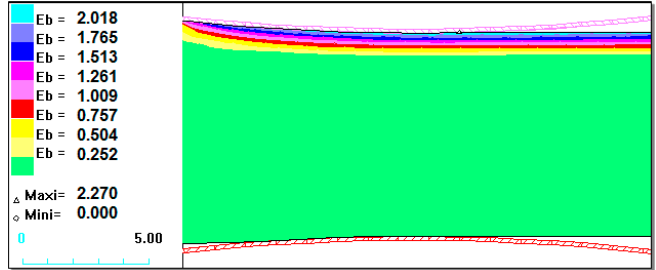
Figure 3. State of strain intensity for the Ni–5%Al alloy coating for 5% relative draft with a different coating thicknesses at the upper part rolling band of h p = 0.6 mm.